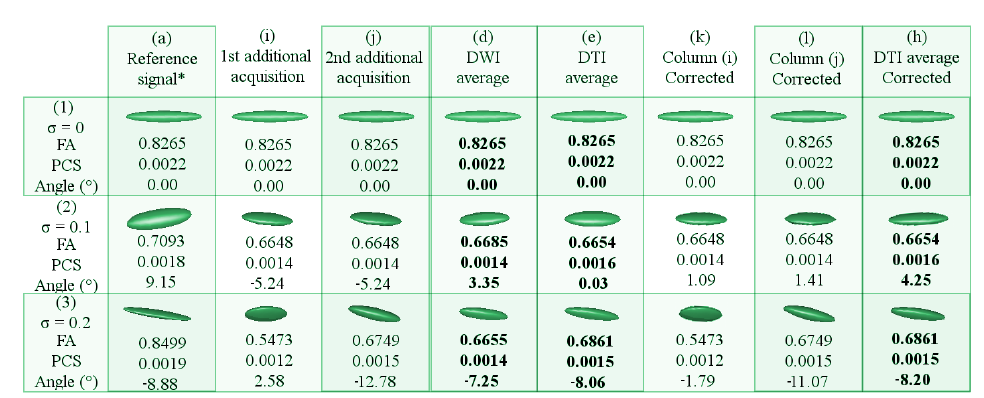
Figure 6: Results of the theoretical experiment using the new pipeline on synthetic data with no rotation